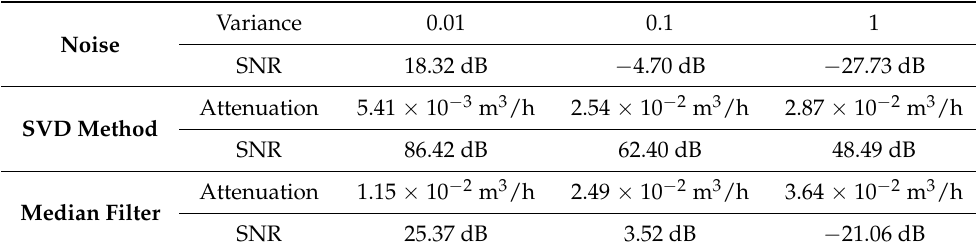
Table 2. Amplitude attenuation and SNR improvement for 8 Hz signal.